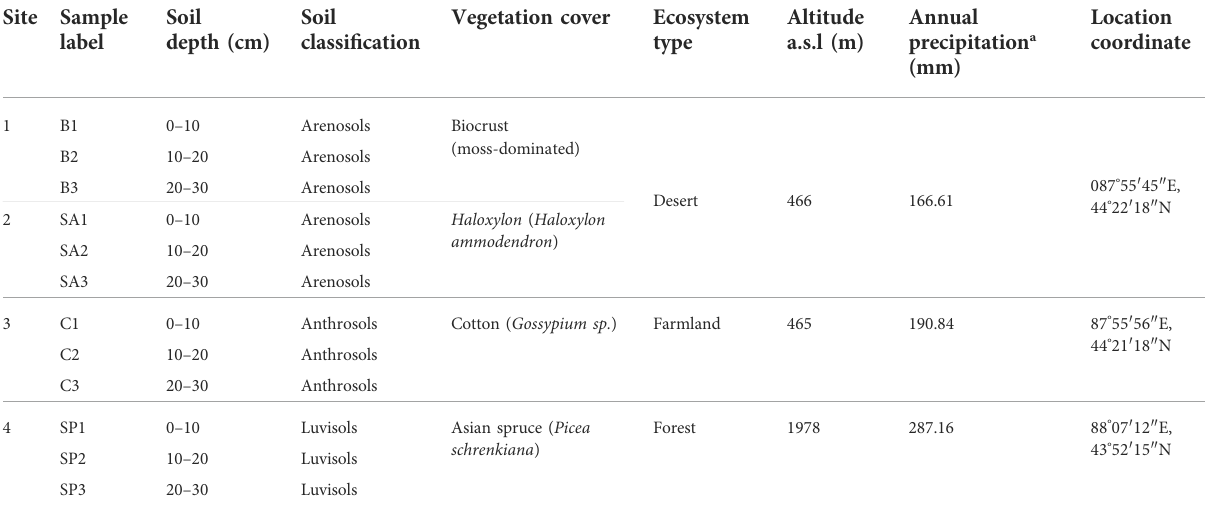
TABLE 1 Sampling information of the soils within four soil sites. Site Sample